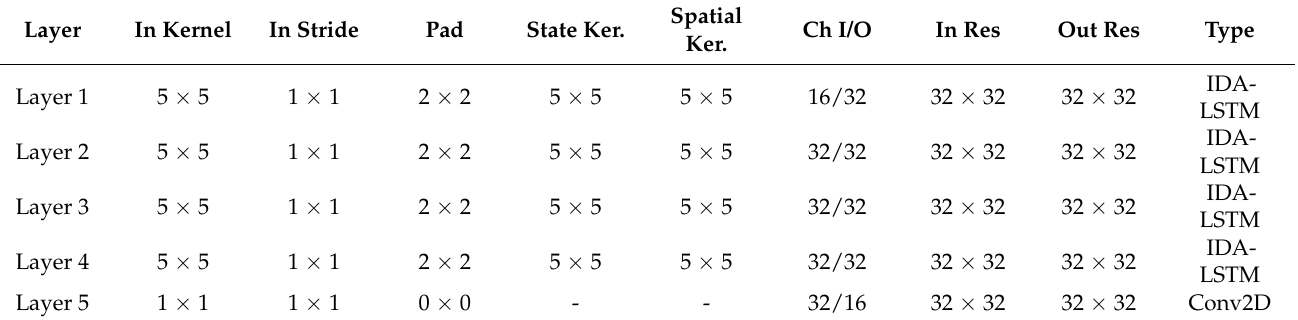
Table 1. The details of the IDA-LSTM model . The output of the Layer 5 will be transform the prediction with same shape of